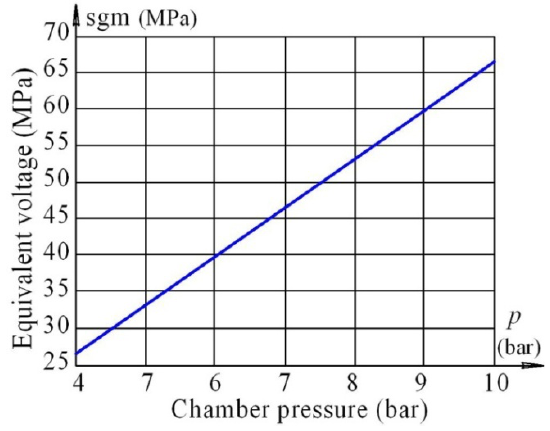
Figure 9. Values of the equivalent voltage, which is determined by the formula (18), depend on the pressure in the chamber